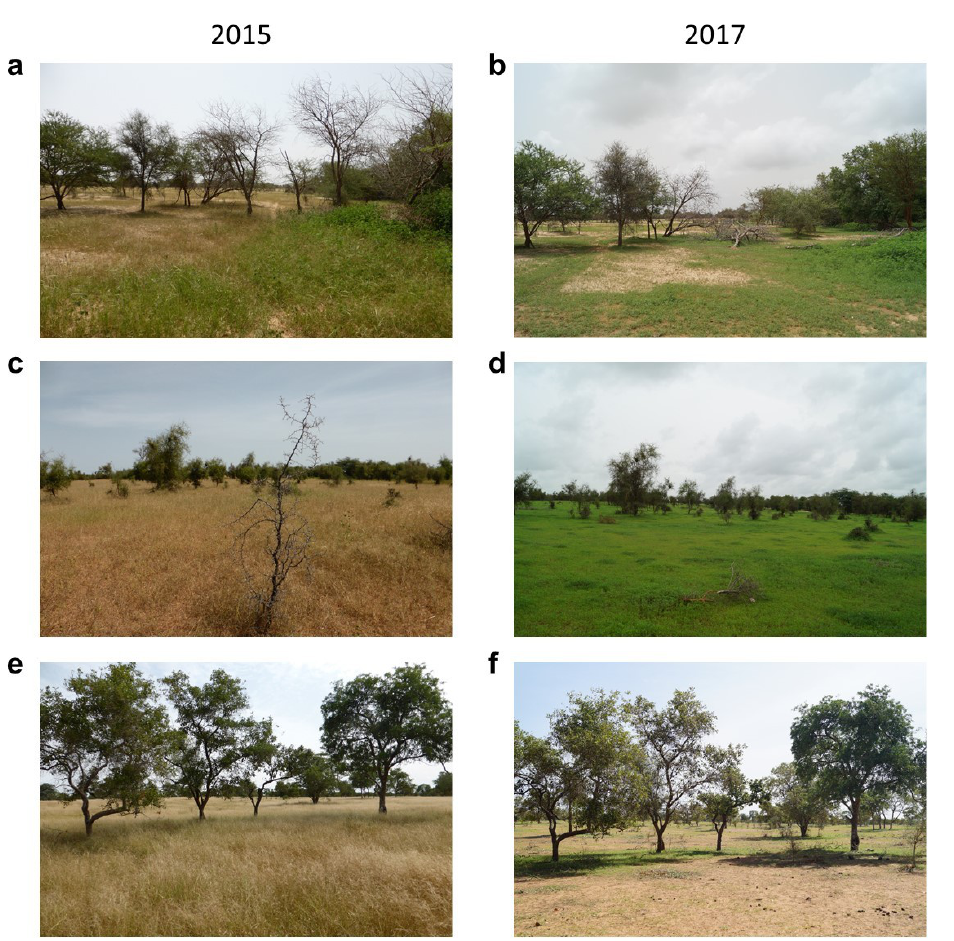
Figure 7. Photos of three transects sampled during the field campaign of 2015 and revisited in 2017. ( a , b ) Transect 9 was located in shallow ferrugineous soils. Two big G. senegalensis individuals that appeared dead in the 2015 photo were not present anymore in 2017 (it is a common practice in the region to collect wood from dead trees and shrubs), while the acacia and B. aegyptiaca individuals remained. ( c , d ) Transect 16 and ( e , f ) transect 13 were located in more sandy soils and the lower amount of dead woody individuals in those transects is clear. Although a visual assessment of the recovery after two years should be treated with caution, the growth of new G. senegalensis and B. aegyptiaca individuals is already observed in ( f